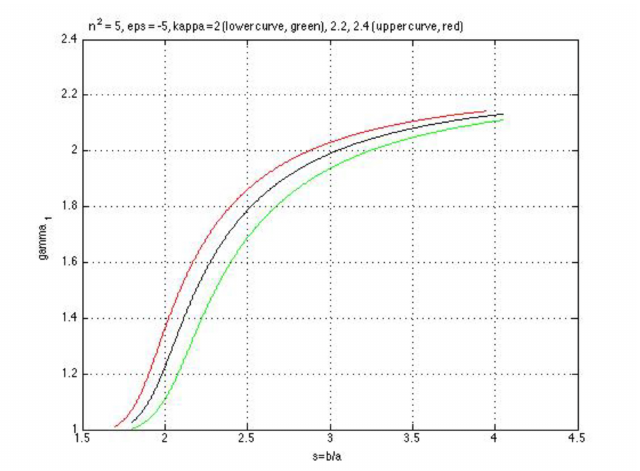
Figure 11: Plots of γ 1 = γ 1 ( κ ) solving DE (11), (12) of the fundamental GL surface modes vs s = b/a for κ = 2 (lower green curves), 2.2, and 2.4 (upper red curves) at (cid:15) = − 4